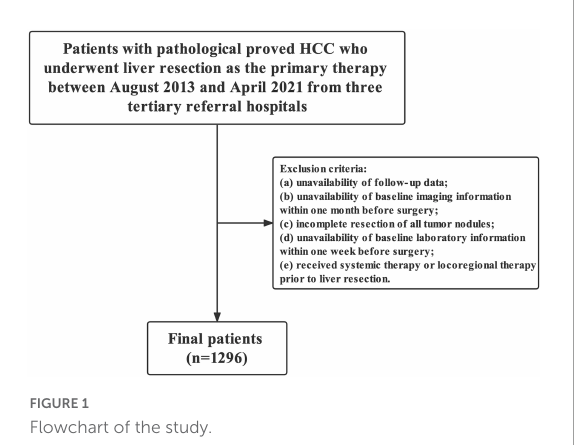
FIGURE1 Flowchart of the study.